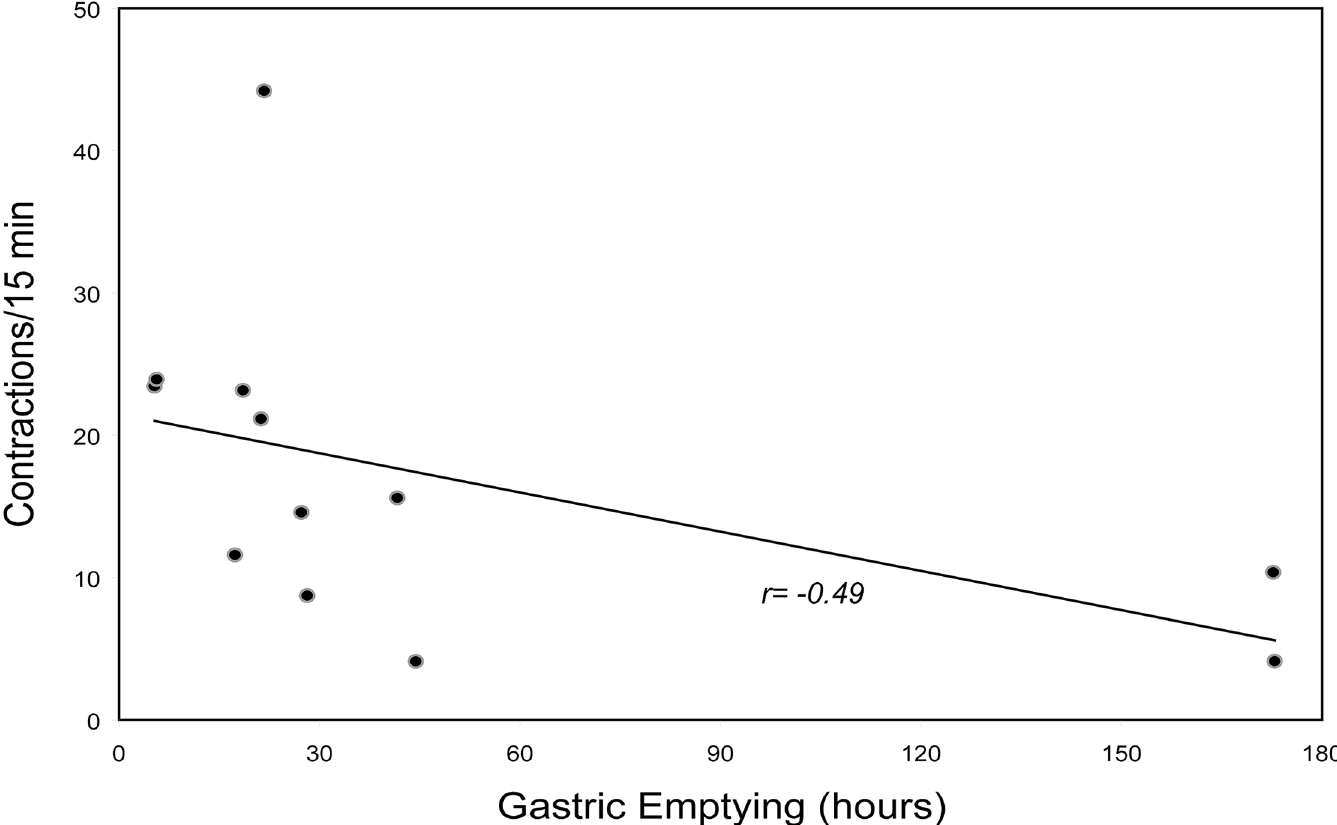
Fig 4. Correlation of Colon Contraction Numbers with Gastric Emptying. The correlation of overall numbers of colon contractions with gastric emptying times is plotted for diabetics with gastroparesis. There was a moderately good inverse correlation (r value -0.49) with patients with the most severe emptying delays exhibiting lower numbers of